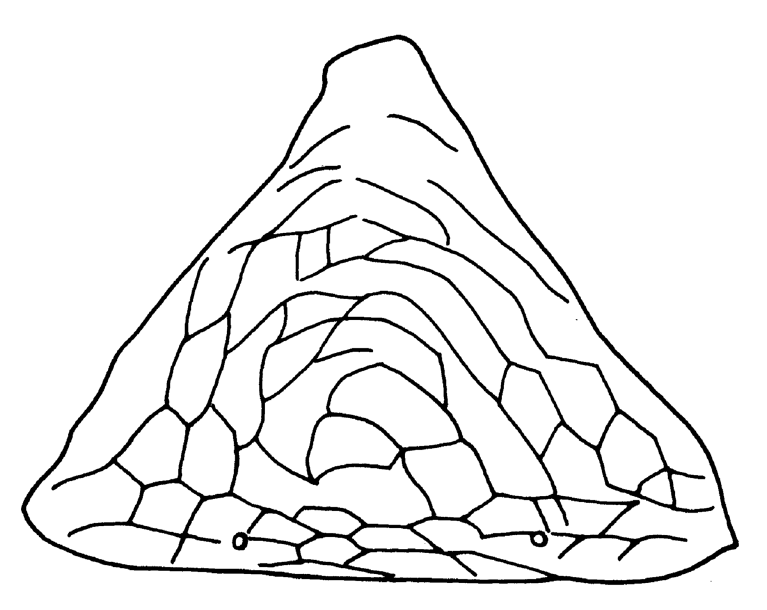
Figures 7. Haplothrips shivendraii sp. n.: Pelta, female